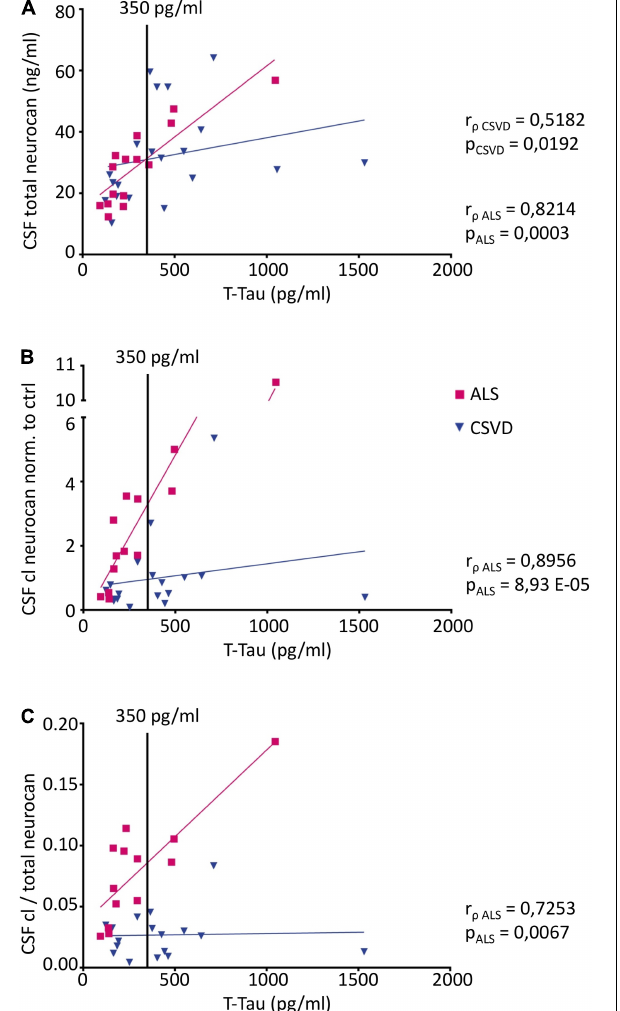
a disease-specific mechanism not explained by